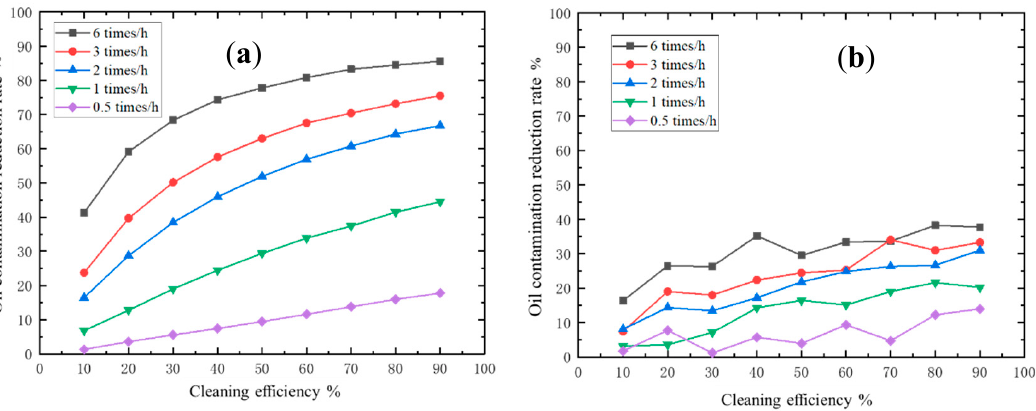
Figure 10. Relationship between oil contamination reduction rate on different surfaces and different cleaning rates under different cleaning frequencies: ( a ) workbenches in the production area and ( b ) assembly tables in the assembly area.